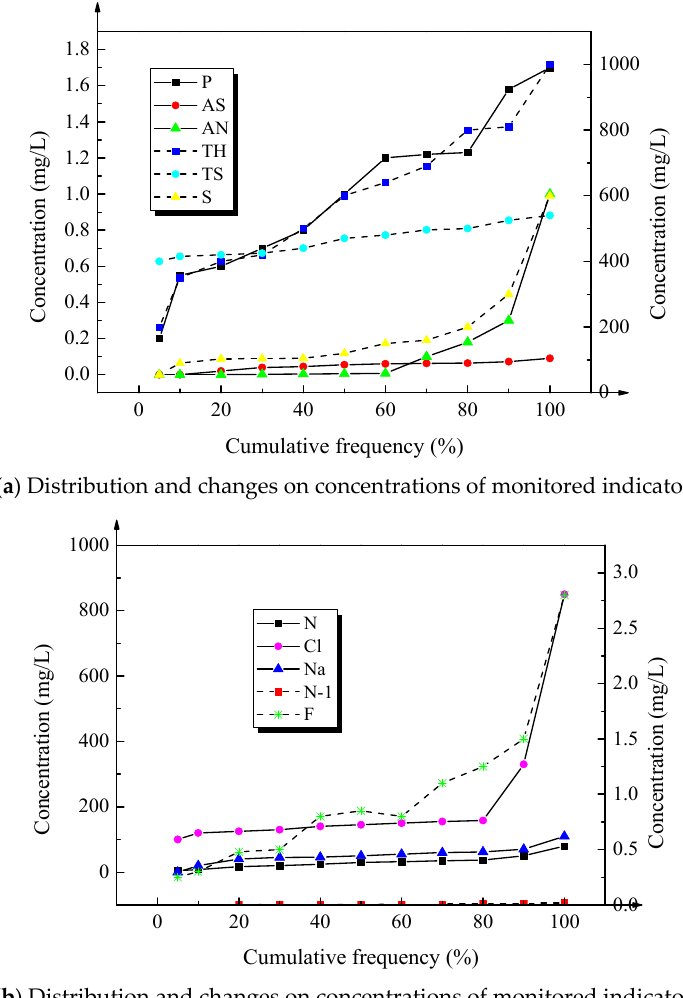
Figure 3. Distribution and changes on concentrations of monitored indicators. (In the above figures, P, AS, AN, TH, TS, S, Cl, Na, N-1, and F refers to the permanganate, anionic surfactant, ammonia nitrogen, total hardness, total dissolved solids, sulfate, nitrate, chloride, sodium, nitrite, and fluoride, respectively.) Note: considering that there are multiple monitoring indexes, the results are given in two figures.